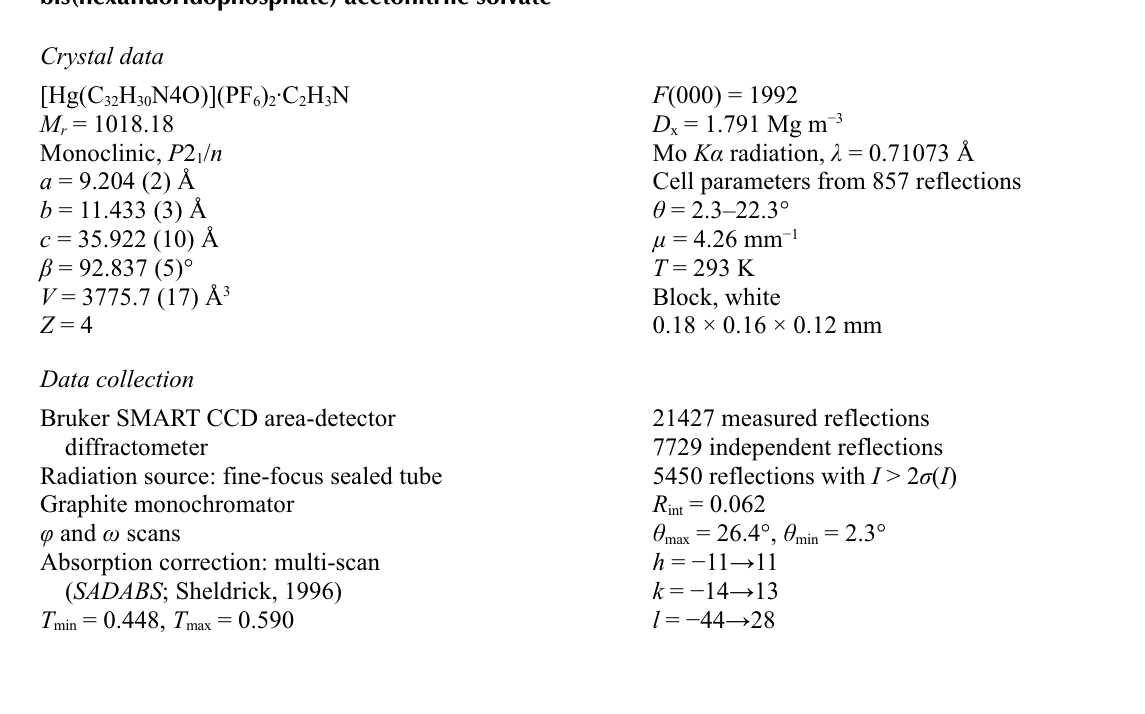
sup-2 Acta Cryst. (2009). E 65 , m217